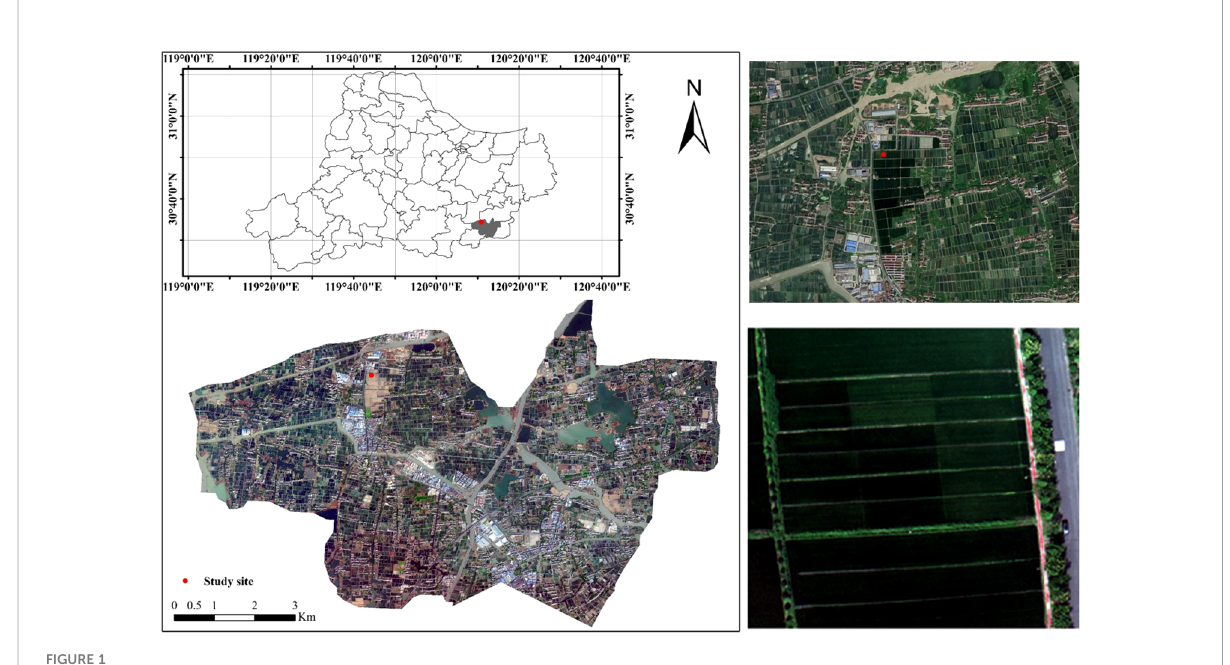
FIGURE 1 Study area and experimental site.